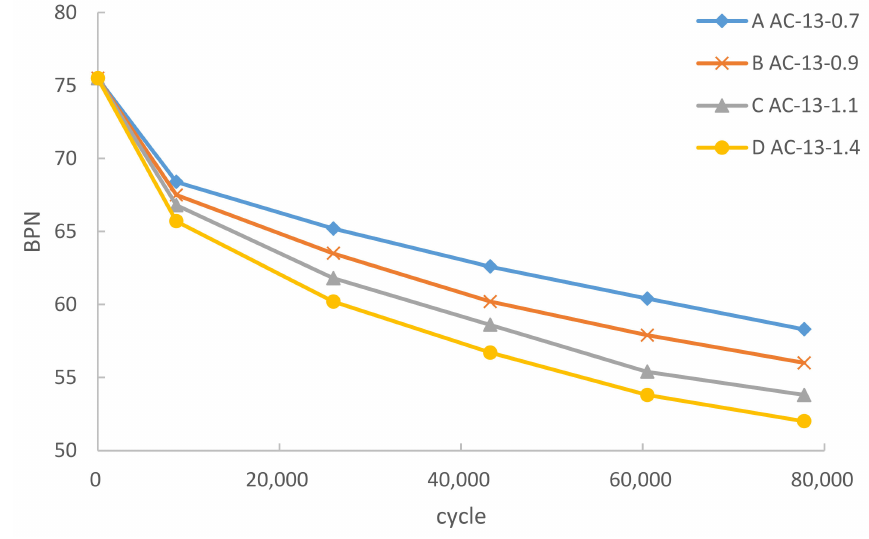
Figure 6. Heavy load e ff ect on the British pendulum